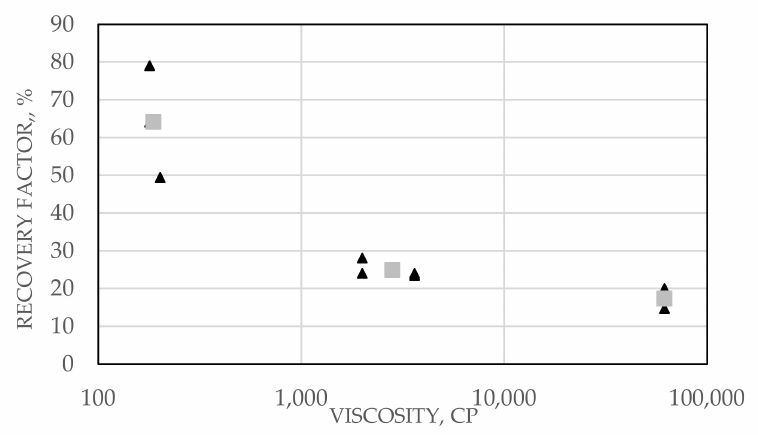
Figure 8. Incremental recovery factor and viscosity dependence for secondary recovery.